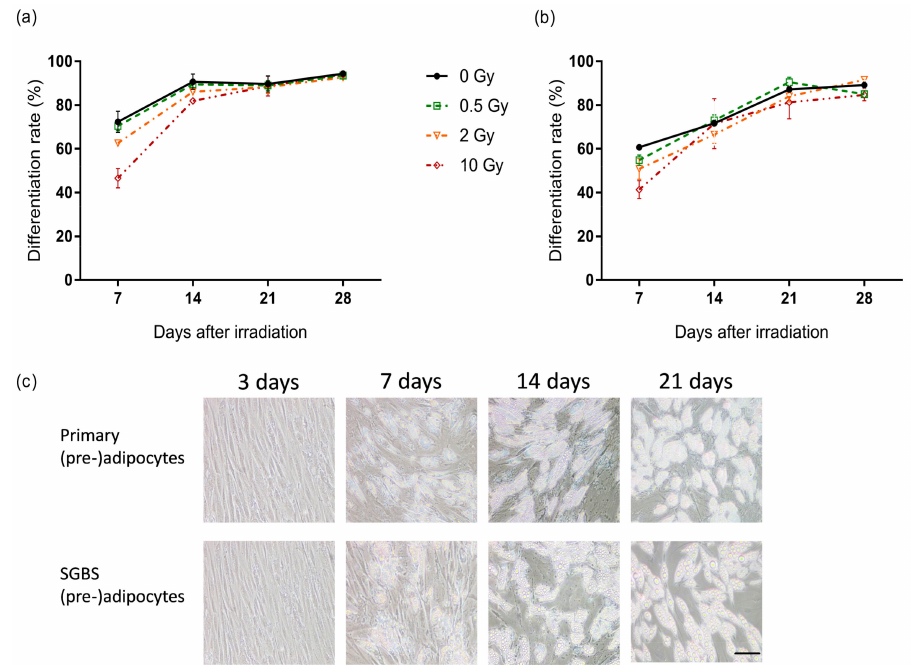
Figure 4. Effect of X-ray irradiation on adipogenic differentiation. ( a ) Human primary pre-adipocytes and ( b ) SGBS pre-adipocytes were exposed to 0.5, 2 and 10 Gy X-rays and differentiation was initiated. The cells were stained with Oil Red O at indicated days and the differentiation rate was calculated as a ratio of the number of differentiated cells and the total cell number. Mean, SEM, N = 3; ( c ) Representative pictures of (pre-) adipocytes at different stages of differentiation. Scale bar represents 100 µ m.